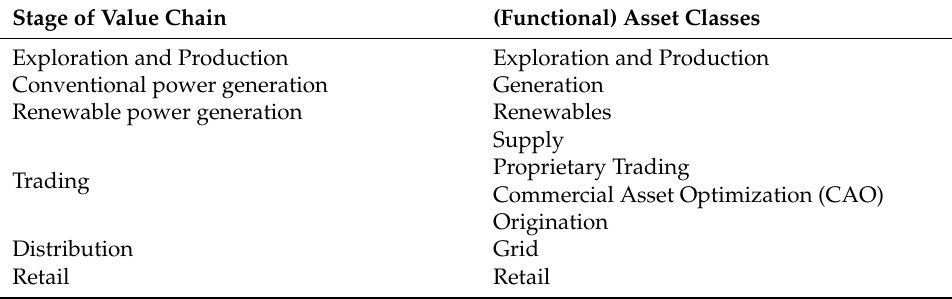
Table 3. Value chain stages and (functional) asset classes